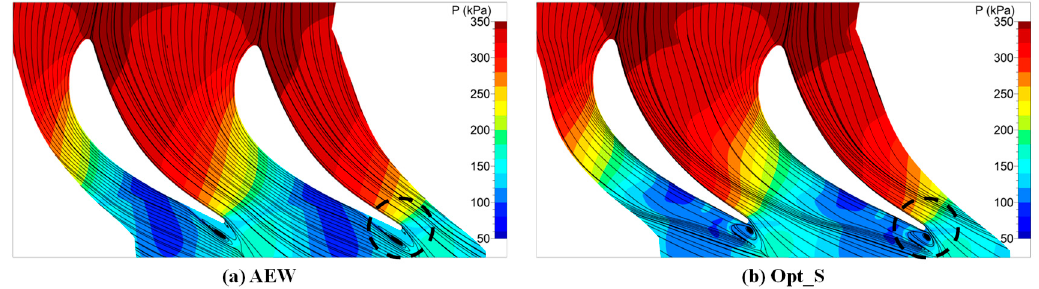
Figure 7. ( a , b ) Limiting streamlines and static pressure contours at the stator hub.